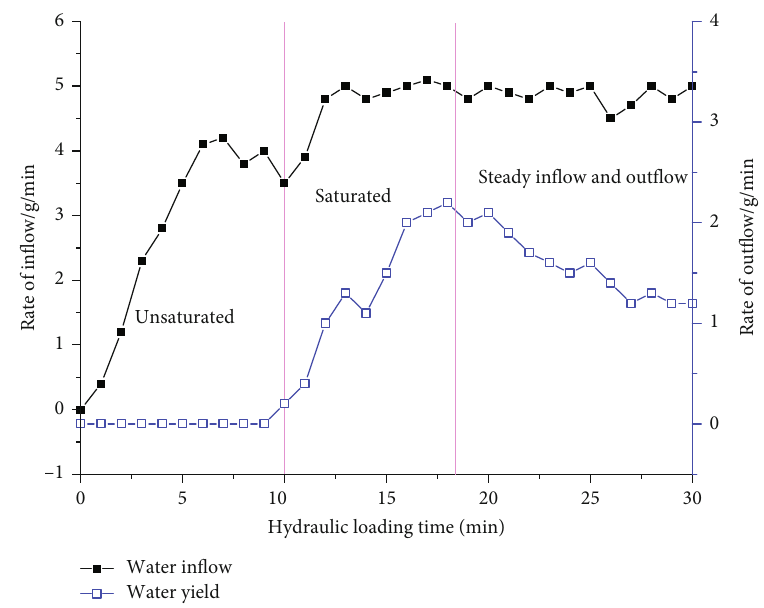
Figure 4: In fl ow and out fl ow rate